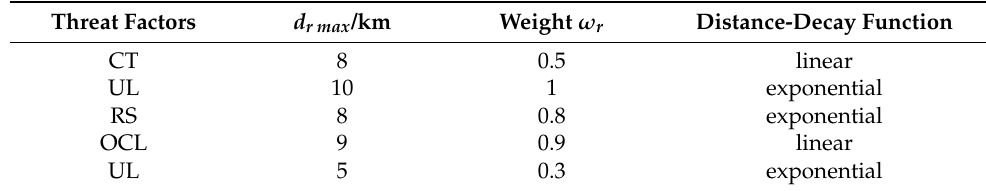
Table 2. Threats and their maximum influence distances and weights.